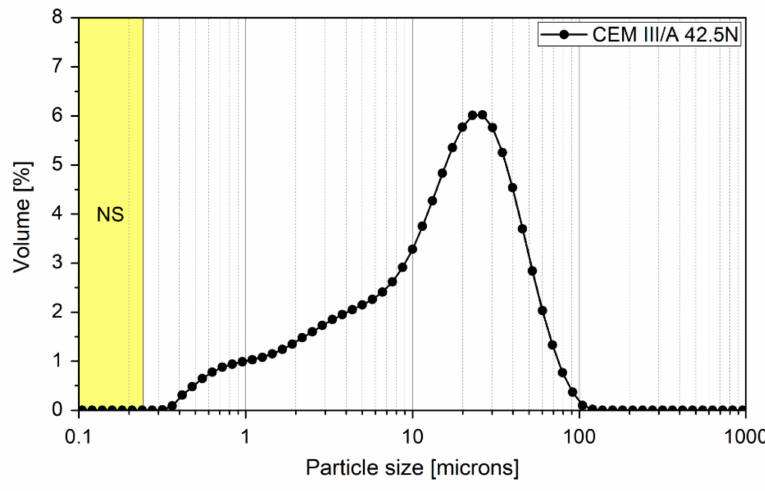
Figure 2. Particle size distribution of cement and river sand used in this study. The particle size range (based on TEM analysis) of silica nanoparticles has been highlighted in